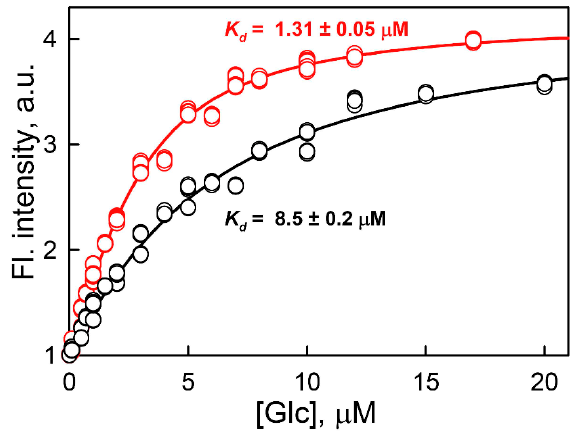
Figure 5. Dependence of the BADAN fluorescence intensity linked to GGBP/H152C on glucose concentrations [Glc] in solution without denaturants (black curve) and in the presence of 0.1 M GdnHCl (red curve). The excitation and emission wavelengths were 387 and 545 nm, respectively. The greater affinity of GGBP to glucose in the presence of low GdnHCl concentrations was also manifested by an increase in the binding rate of glucose to the protein in the presence of 0.1 M GdnHCl. It is known that, at high concentrations of one of the reactants, the reaction rate is predominately determined by the content of the substance with a low concentration (pseudo-first order conditions) [88–90]. Therefore, it can be expected that in solutions of high glucose concentration, the rate of the GGBP/H152C-glucose complex formation will be determined by the content of molecules with the semi-closed conformations in a protein ensemble. The kinetics of the glucose binding to GGBP/H152C at the ligand excess conditions were studied by the stopped-flow technique in solutions without denaturant and in the presence of sub-denaturing GdnHCl concentrations.